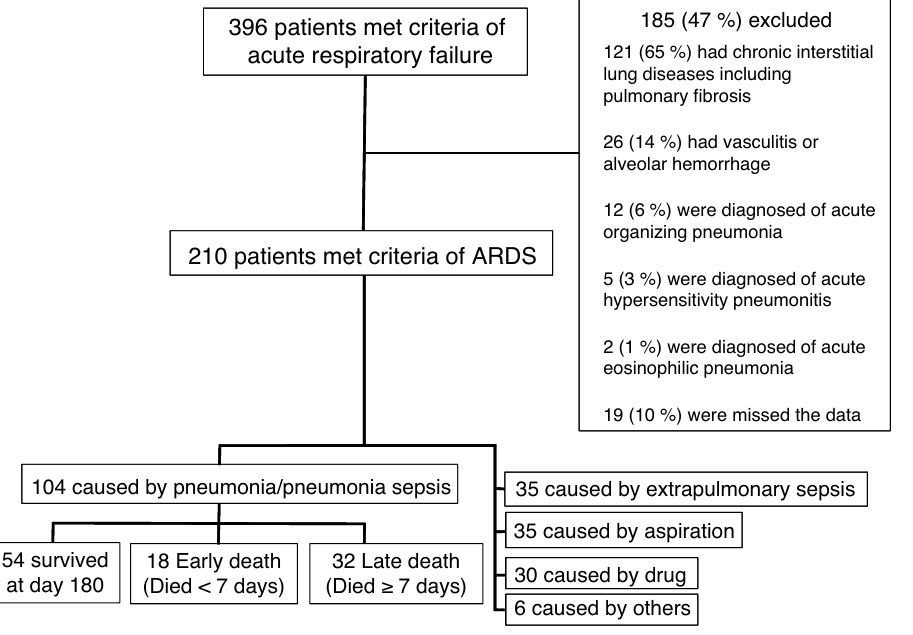
Figure 1. Screening and enrollment of patients with acute respiratory distress